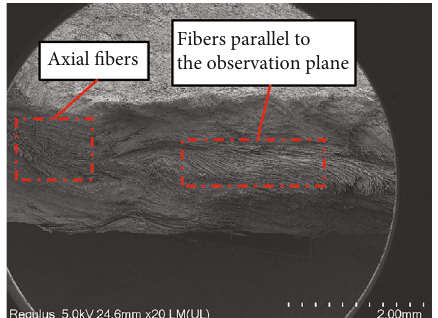
Figure 6: SEM microstructure of strong arrangement.